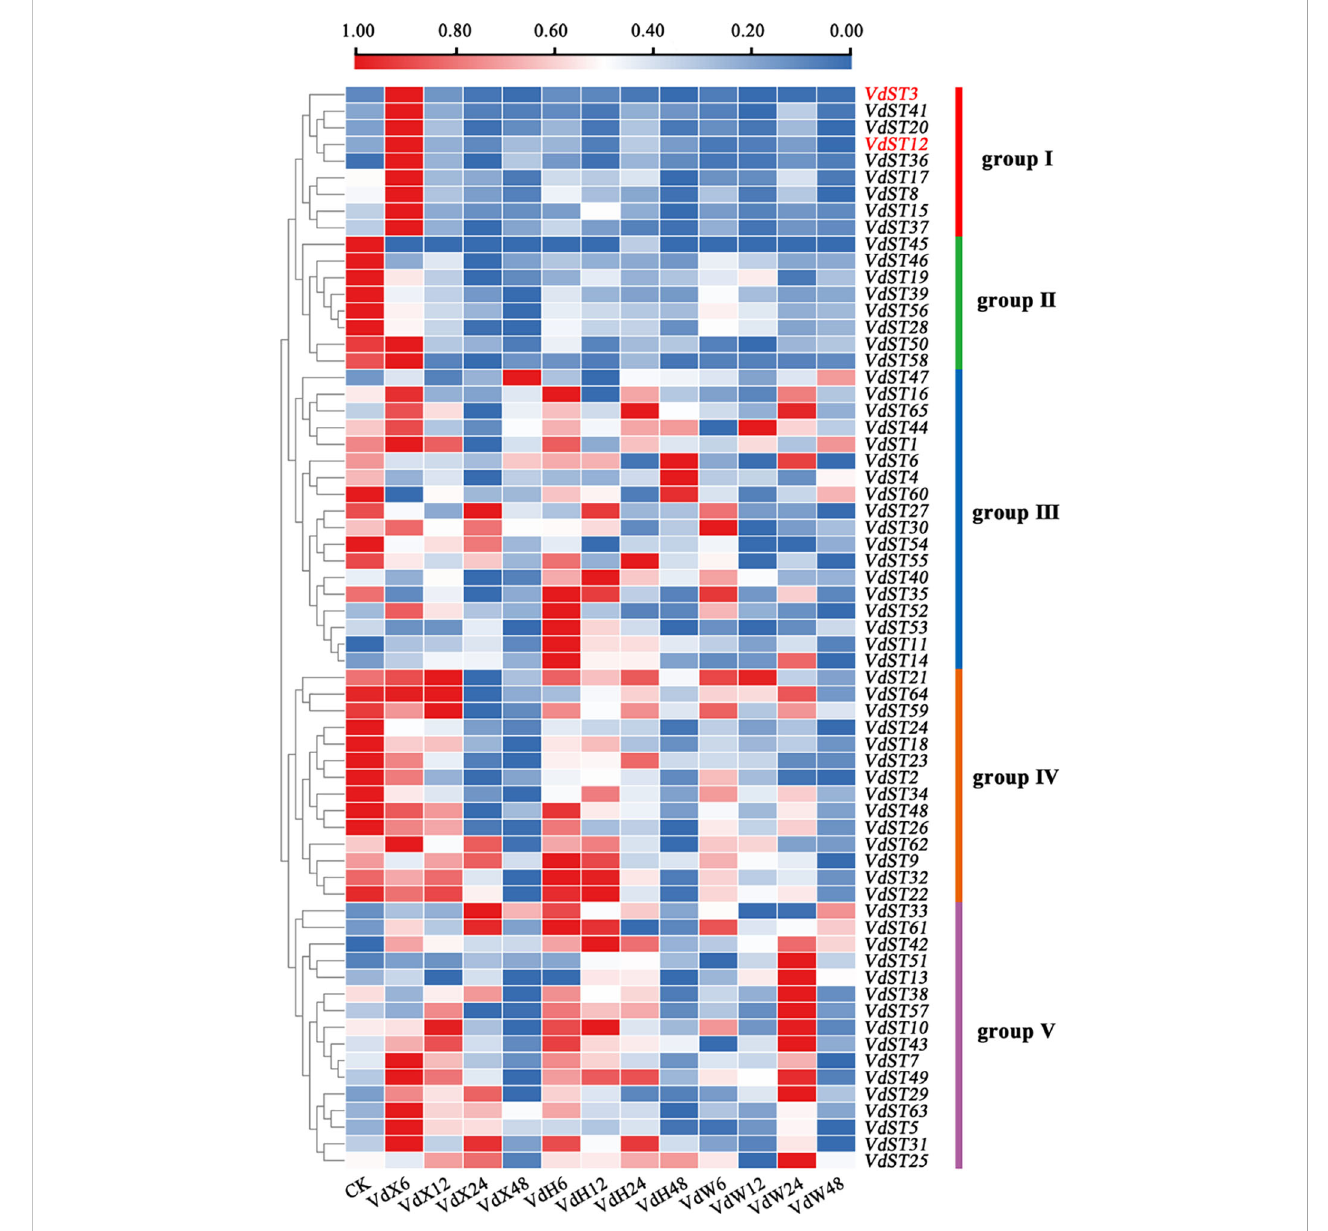
FIGURE 3 Expression pro fi le analysis of the 65 VdST genes after sensing root exudates from different cotton varieties. VdX6, 12, 24, and 48 represented V. dahliae samples cultured by root exudates from the susceptible cotton variety (Xinluzao 7) for 6, 12, 24 and 48h, respectively. VdH6, 12, 24, and 48 represented V. dahliae samples cultured by root exudates from the resistant cotton variety (Hai7124) for 6, 12, 24 and 48h, respectively. VdW6, 12, 24, and 48 represented V. dahliae samples cultured in water for 6, 12, 24 and 48h, respectively. The color of the scale bar, ranging from blue to red, represented low to high expression. The two genes ( VdST3 and VdST12 ) selected for further study were highlighted in